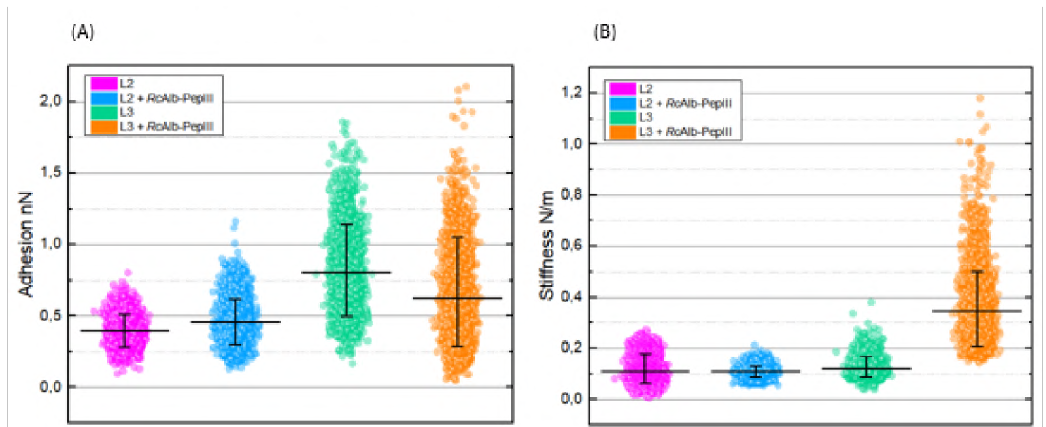
Figure 6. Quantitative adhesion ( A ) and stiffness ( B ) data on H. contortus surface in phases L2 and L3 without surface treat- ment and treated with RcAlb -PepIII. For each sample, 65,536 force curves were obtained, each curve providing corresponding adhesion and stiffness values. The higher number of points analyzed were used to produce the standard